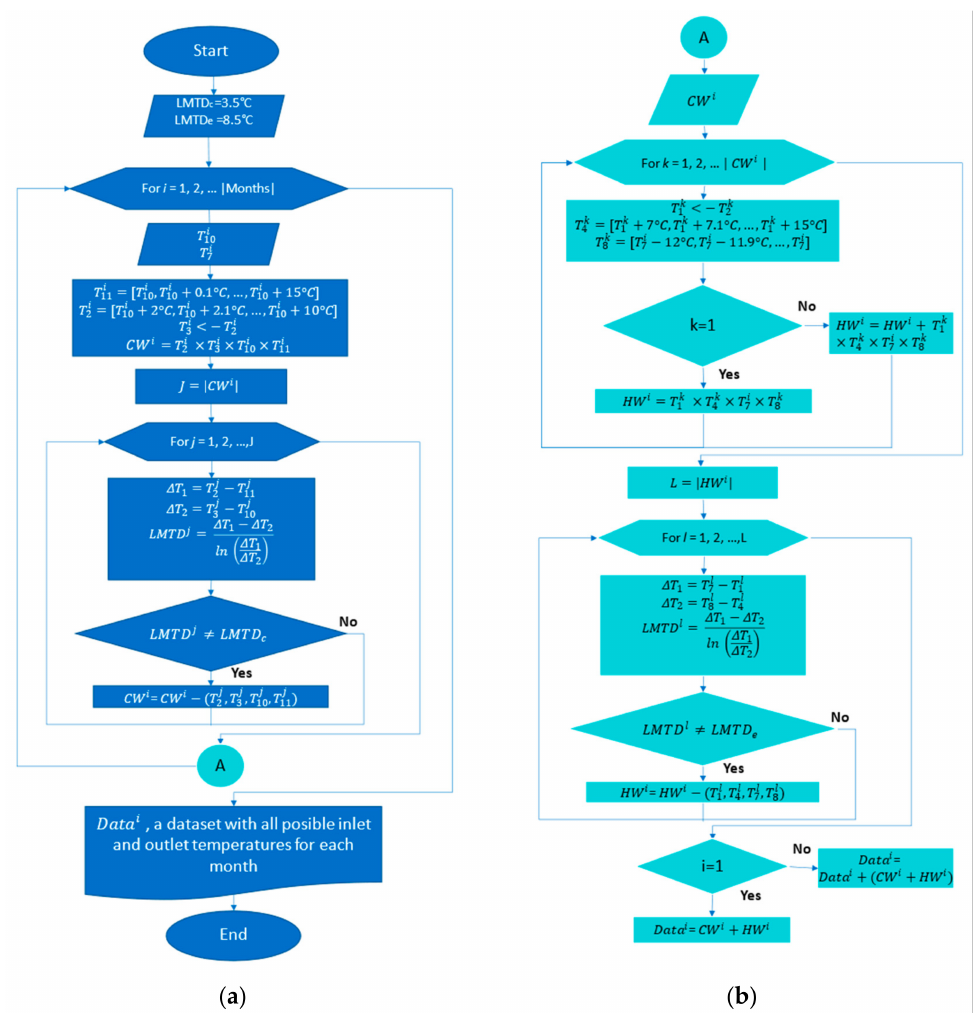
Figure 3. Diagram of the logarithmic mean temperature difference ( LMTD ) algorithm used to determine possible inlet and outlet temperatures for heat exchanger ( a ) for the complete function and ( b ) for the function connected